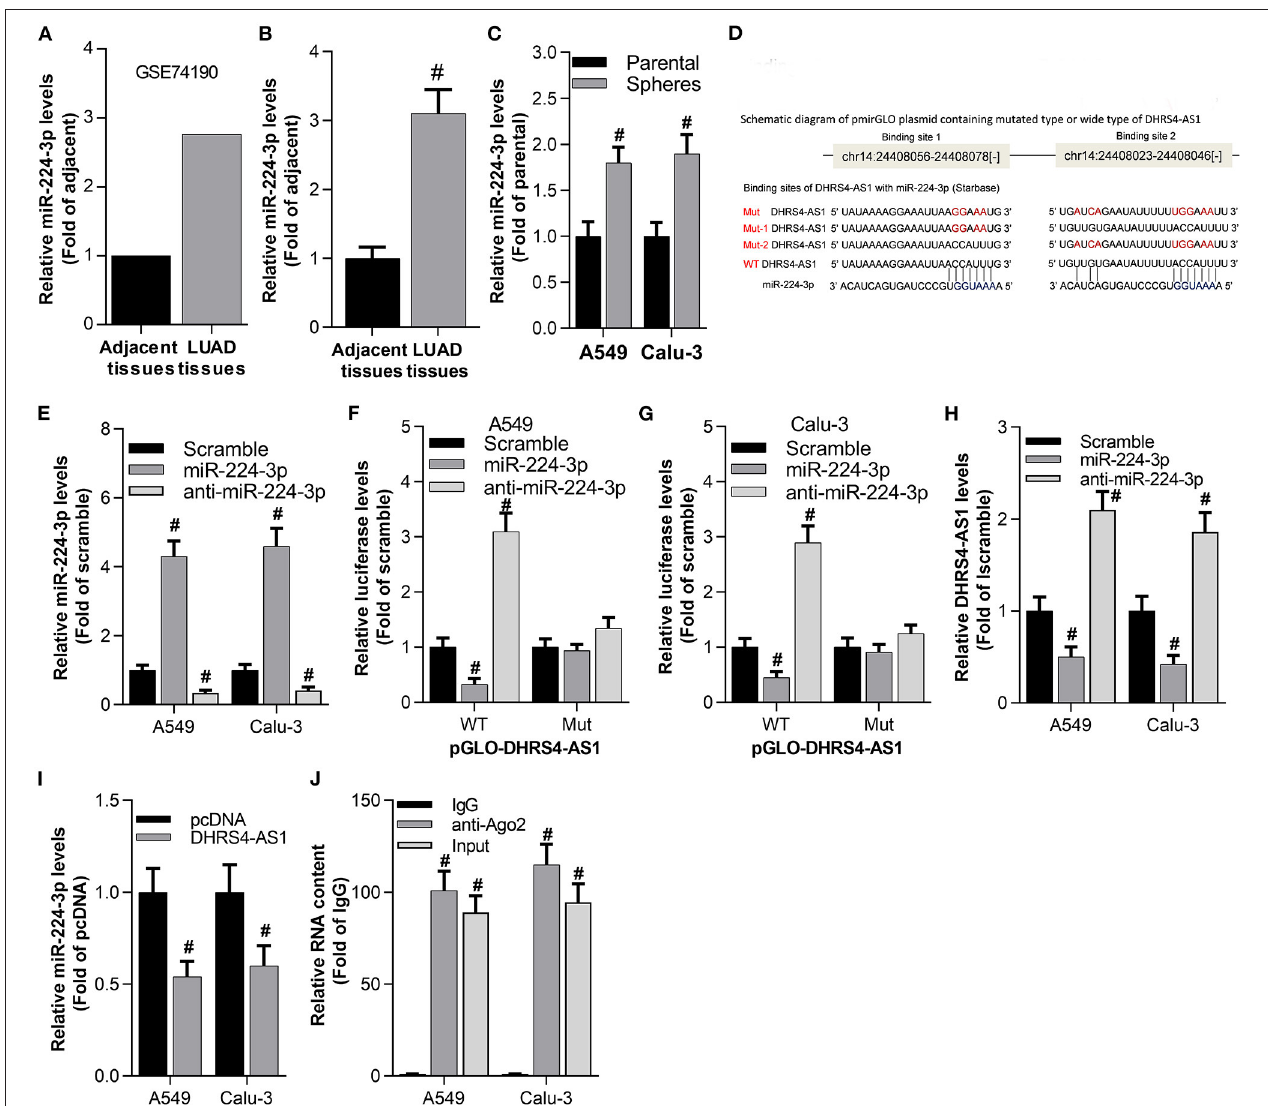
FIGURE 3 | Antagonistic repression between DHRS4-AS1 and miR-224-3p in NSLC cancer cells. (A) Bioinformatics analysis of miR-224-3p expression in the GSE74190 dataset as determined by GEO2R analysis. (B) Real-time PCR analysis of miR-224-3p expression in lung cancer ( N = 83) and adjacent ( N = 83) tissues; # p < 0.01 vs. adjacent tissues. (C) Real-time PCR analysis of miR-224-3p expression in parental cells and A549 and Calu-3 stem cell spheres; # p < 0.01 vs. parental cells. (D) Schematic representation of the predicted miR-224-3p binding sites on the DHRS4-AS1 sequence according to the StarBase analysis. (E) Real-time PCR analysis of miR-224-3p expression after 24h of transfection in A549 and Calu-3 cells; # p < 0.01 vs. scramble. (F,G) Luciferase assay showing pGLO-DHRS4-AS1-WT (wild type) and pGLO-DHRS4-AS1-Mut (Mut) after 24h of transfection in mock-, miR-224-3p- or anti-miR-224-3p-transfected A549 and Calu-3 cells; # p < 0.01 vs. scramble. All data was normalized to wildtype control group (WT Scramble) (H) Real-time PCR analysis of DHRS4-AS1 expression after 24h of transfection in A549 and Calu-3 cells; # p < 0.01 vs. scramble. (I) Real-time PCR analysis of miR-224-3p expression in A549 and Calu-3 cells after 24h of DHRS4-AS1 overexpression; # p < 0.01 vs. pcDNA. (J) RIP analysis showed that DHRS4-AS1 and miR-224-3p could directly bind to AGO2 in A549 and Calu-3 cells; # p < 0.01 vs. IgG. All the results are expressed as the mean ± SD from three independent experiments, and each sample was repeated in triplicate.